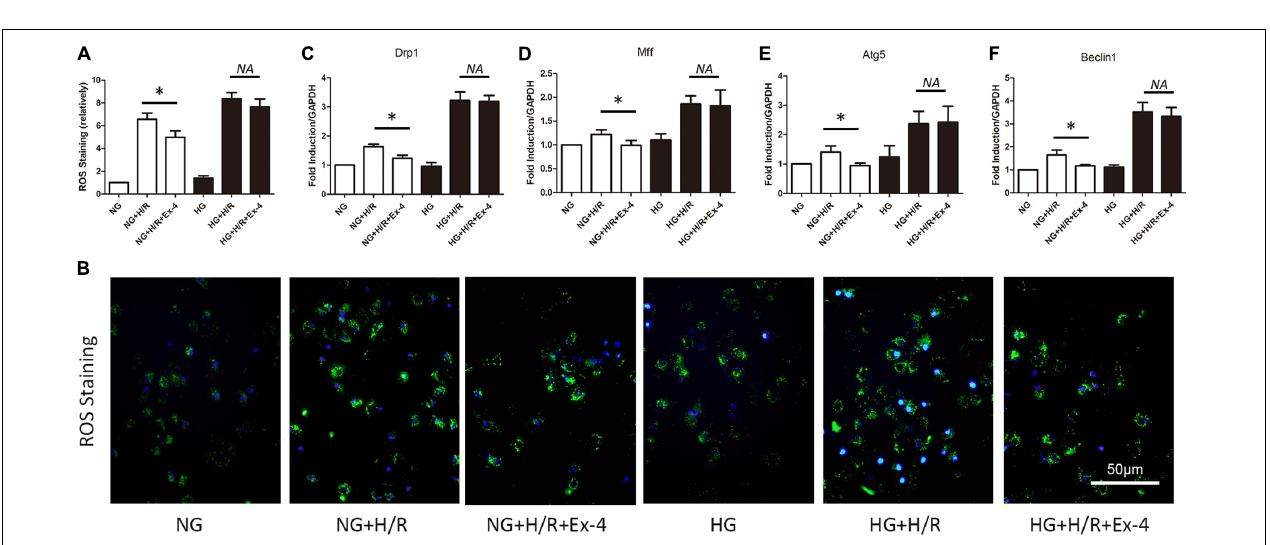
FIGURE 1 | High glucose condition attenuates cardioprotective effects of glucagon-like peptide-1. (A,B) TUNEL staining was conducted and apoptosis index (%) was calculated. (C,D) Anti-apoptotic Bcl-2 and pro-apoptotic BAX were measured using qRT-PCR. (E) Caspase-3 activity was measured using caspase-3 activity kit. (F) Cell viability was measured via CCK-8 assay. * P < 0.05.